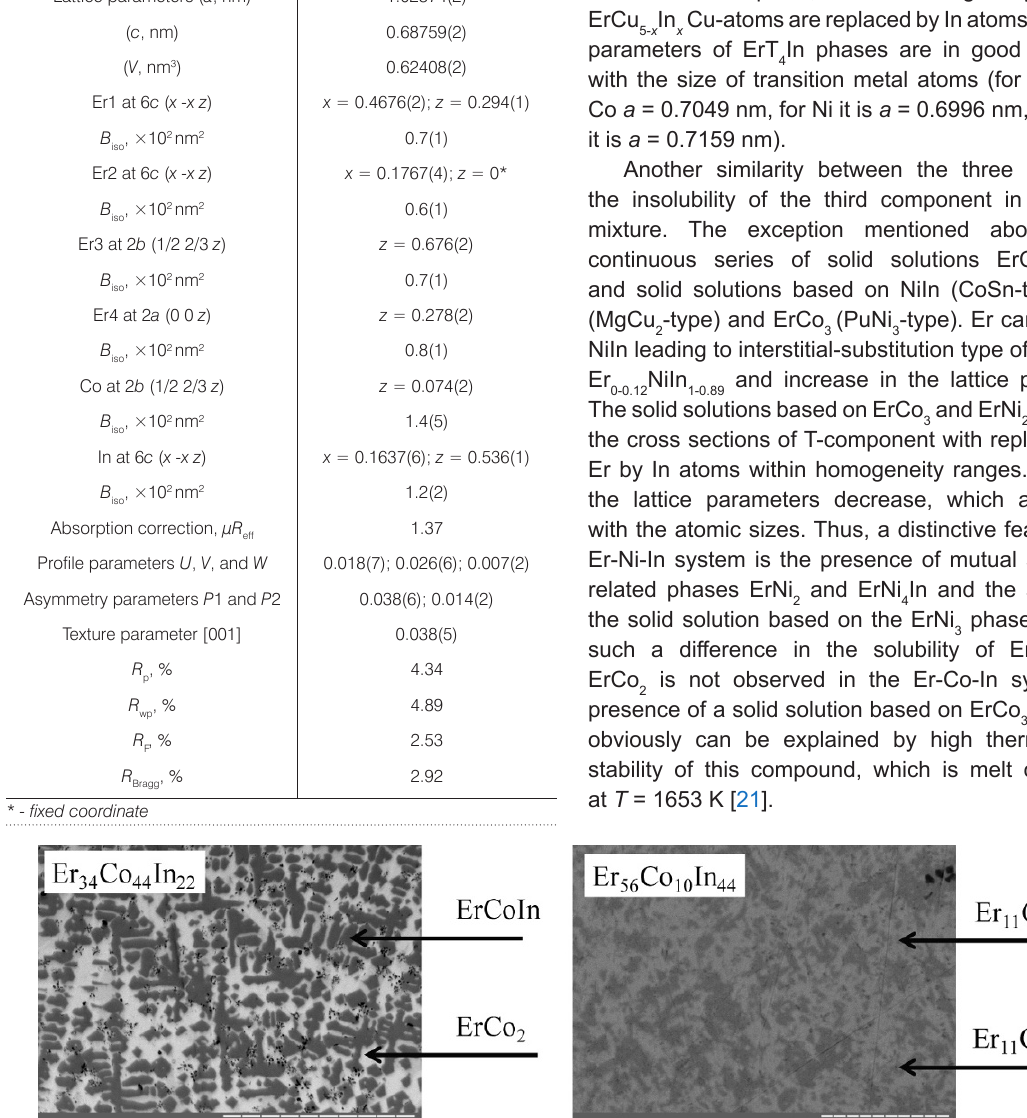
Co In and Er 34 44 22